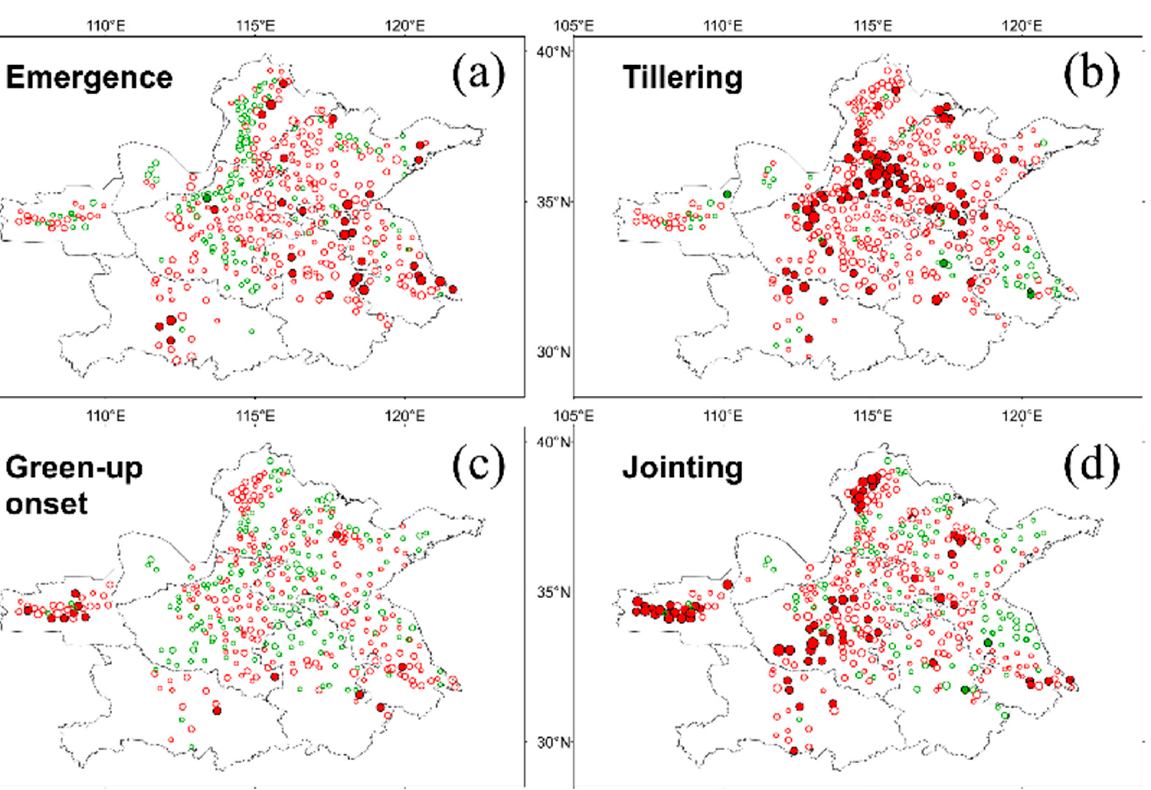
Figure 9. Correlation between phenological dates and corresponding preseason temperature from 1981 to 2016. Red circles represent negative correlations, and green circles represent positive corre ‐ lations. Hollow circles indicate statistically insignificant correlations (P > 0.05), while solid circles indicate statistically significant correlations (P < 0.05). ( a ) represents correlation for emergence, ( b ) represents correlation for tillering, ( c ) represents correlation for green ‐ up onset, ( d ) represents cor ‐ relation for jointing, ( e ) represents correlation for heading, ( f ) represents correlation for milky stage, and ( g ) represents correlation for maturity, respectively.